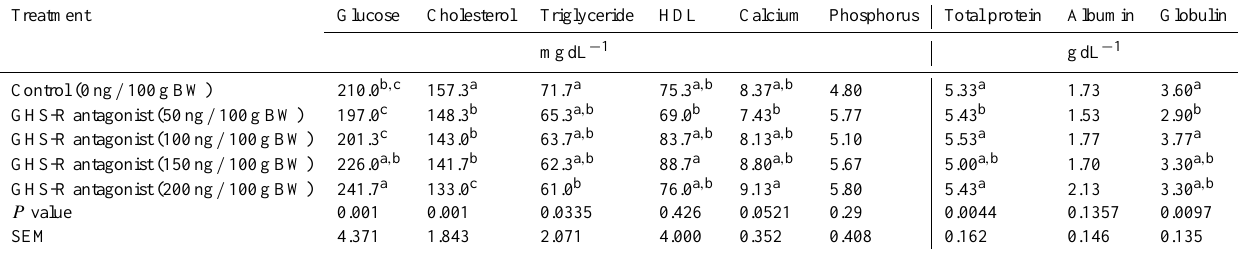
Table 4. Effects of peripheral GHS-R antagonist on biochemical parameters in broiler chicks (42 days). Treatment Glucose Cholesterol Calcium